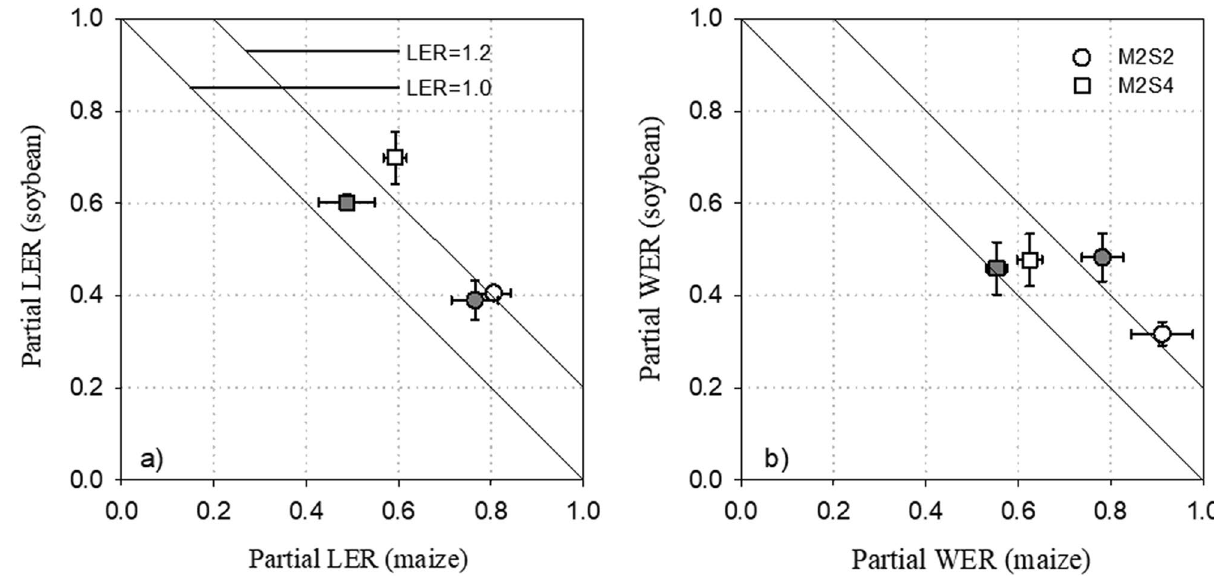
Figure 2. Partial land equivalent ratio (partial LER, a ) and water equivalent ratio (partial WER, b ) of the maize and soybean under intercrop systems in 2012 (white symbols) and 2013 (gray symbols) on the basis of yield. Bars are means ± standard errors.